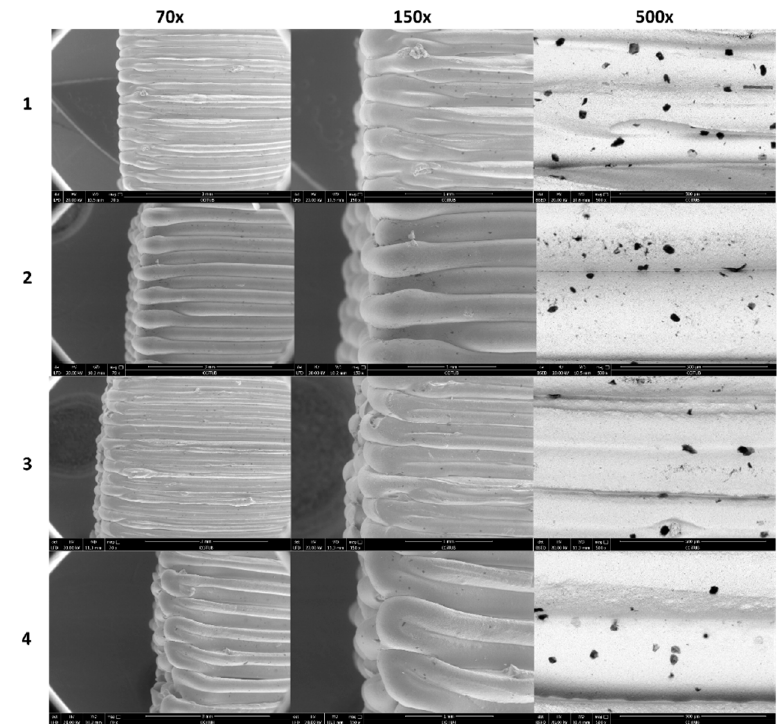
Figure 5. SEM images of the lateral wall of the cuboid of printed lines direction. SE images are 70X and 150X, and BSE images are 500X. Numbers 1, 2, 3, and 4 correspond to the different experiments defined in Table 1.